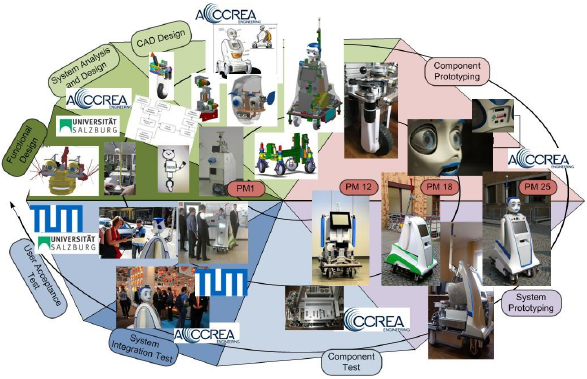
Figure 2: Spiral design of the mechanical construction of IURO and hardware manufacturing.